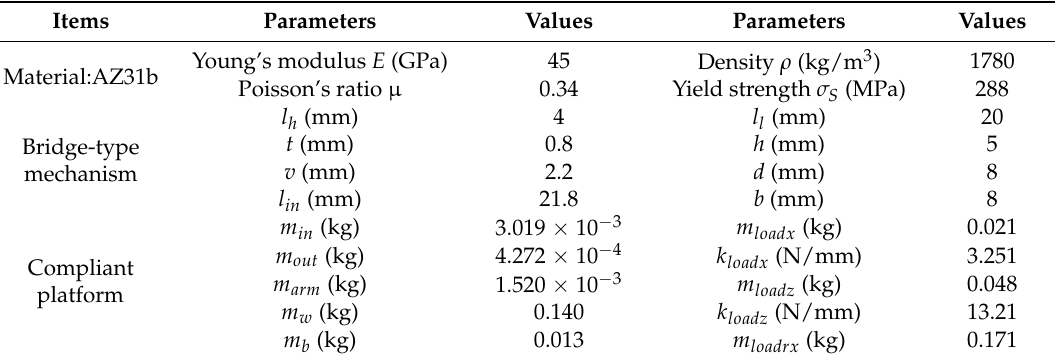
Table 1. Material and mechanical parameters of the compliant platform.